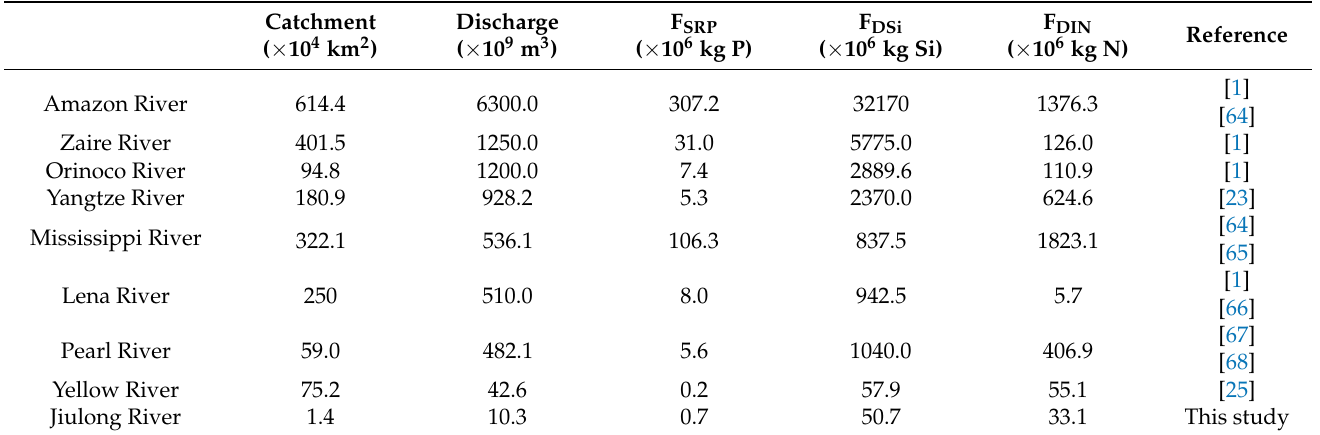
Table 4. A summary of the annual nutrient fluxes ( × 10 6 kg) from worldwide